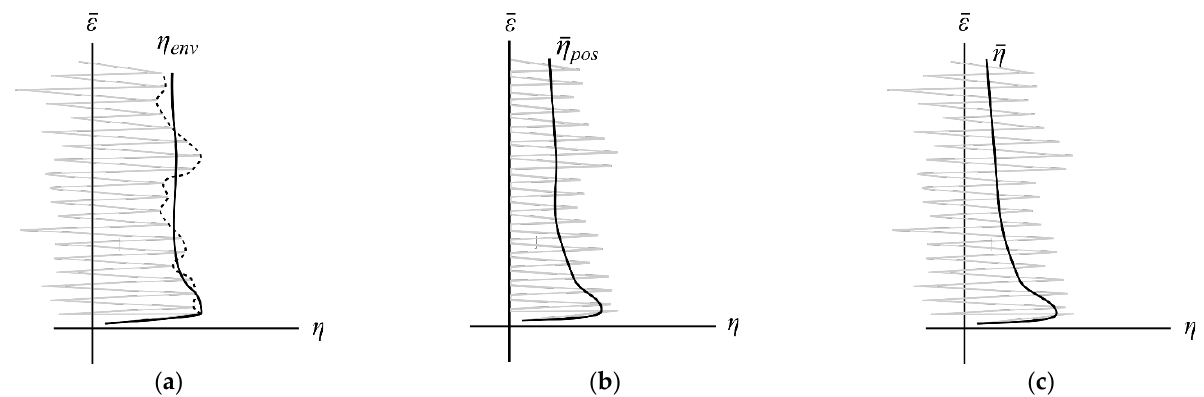
Figure 12. Schematic representation of the non-proportional, cyclic path of incremental tube expansion experienced by an arbitrary tube location with a plot of the ε = f ( η ) evolutions based on the three different integral forms of stress triaxiality: ( a ) envelope stress triaxiality η env , ( b ) average positive stress triaxiality η and ( c ) average stress triaxiality η .